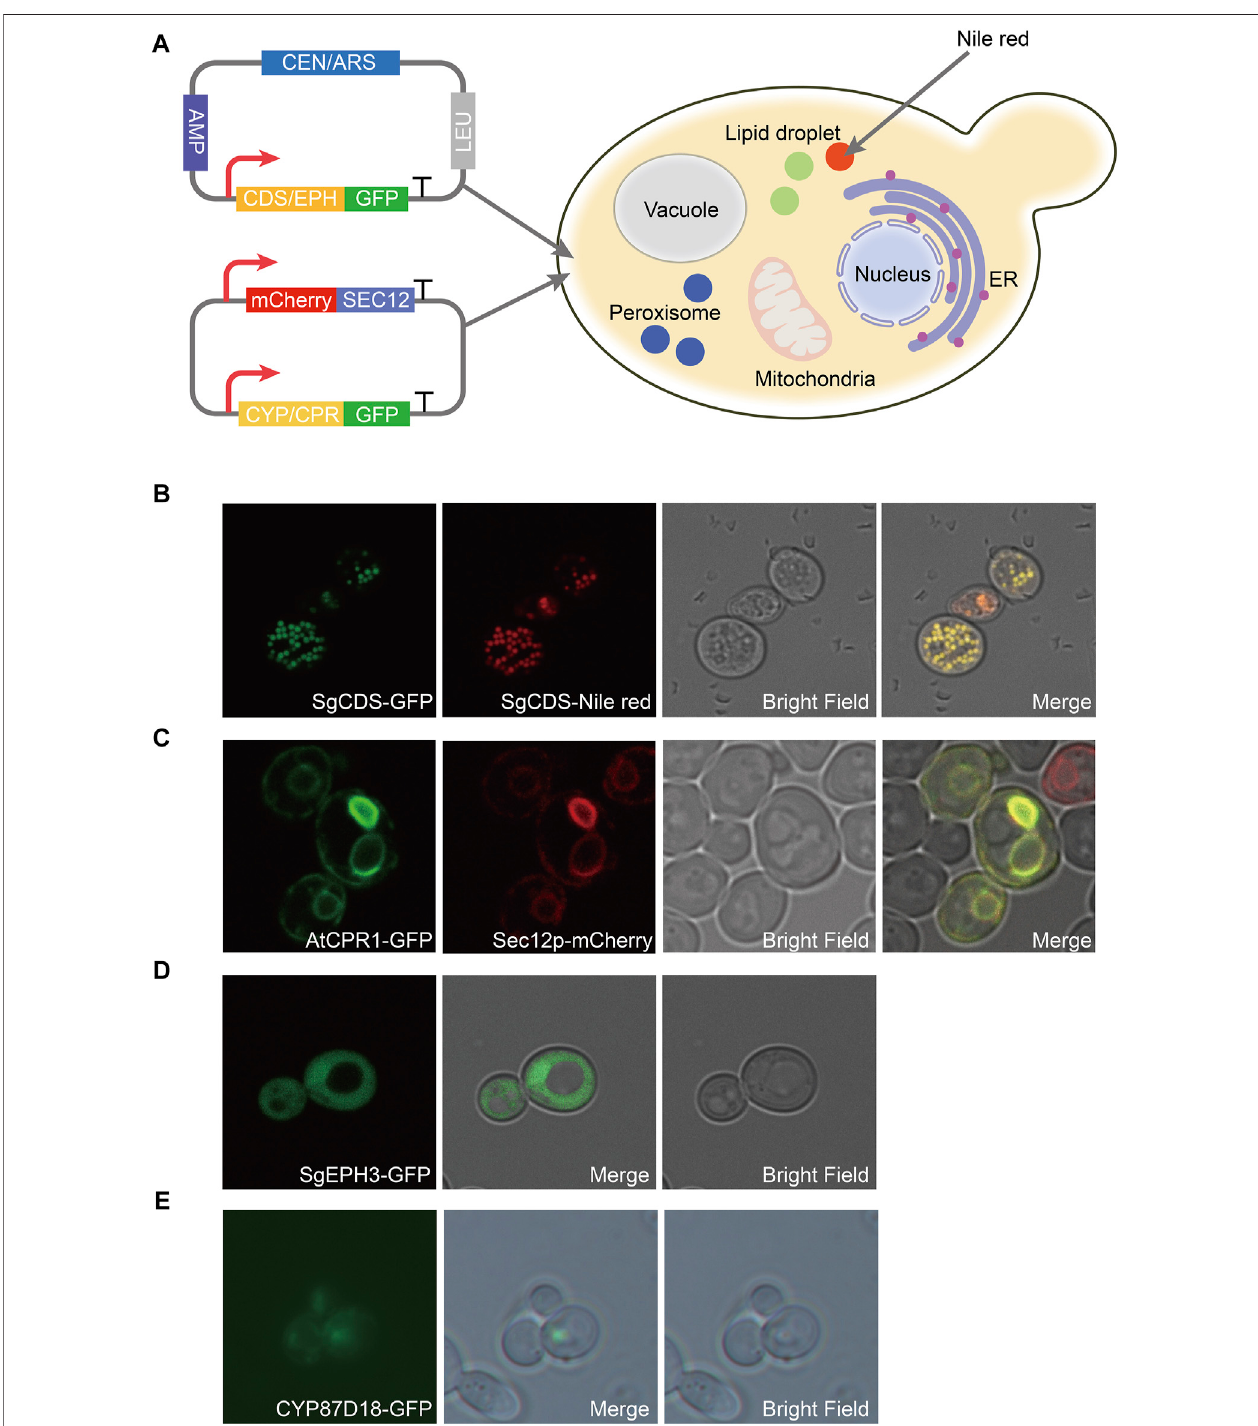
FIGURE2|Distributionofenzymesinvolvedinthesynthesispathwayofmogrol.(A) ConstructionofplasmidspY15-GFPandpY15-GFP-mCherry.SEC12 was proven to be an ER-localized protein. GFP protein was used to visualize the localization of the target protein. mCherry protein was used to speci fi cally mark the ER, and Nile red was used to show intracellular lipophilic regions (B – E) Distribution analysis of SgCDS , SgEPH , CYP87D18 , and AtCPR1 by LSCM, respectively.